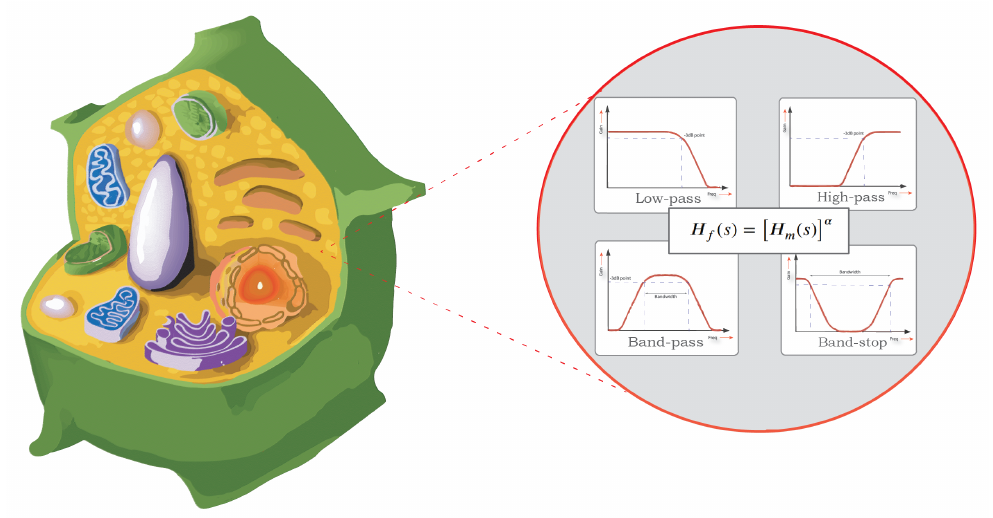
Figure 1. A 3D cross section of a typical plant cell structure and its modelling using power − law